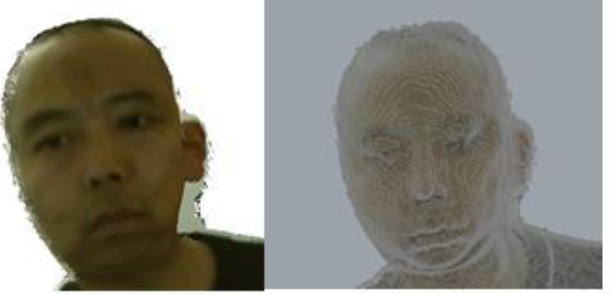
Figure 11. Somatosensory camera.